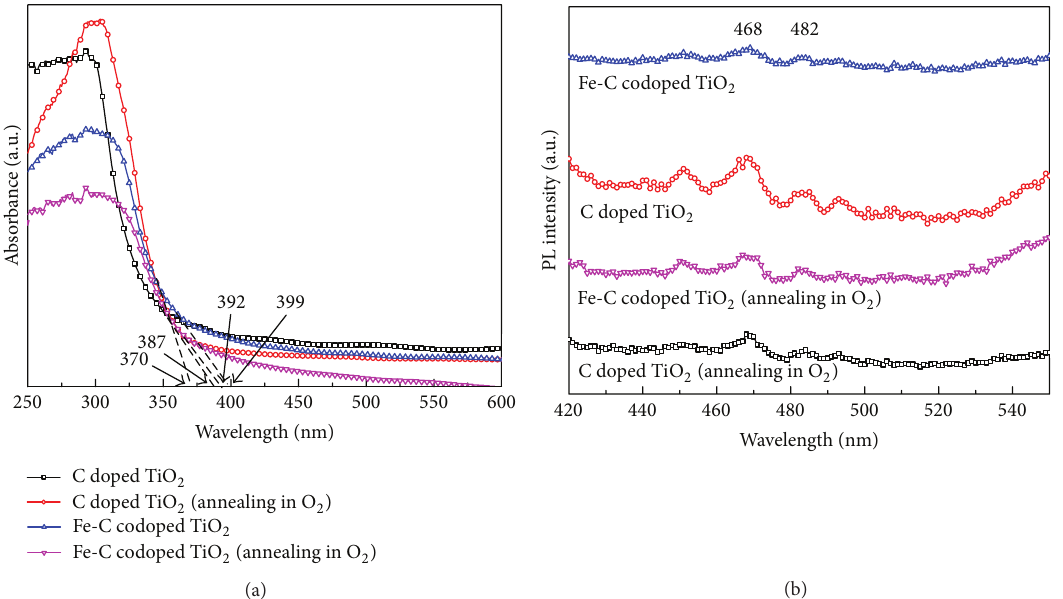
Figure 3: (a) The UV-Vis spectra and (b) PL spectra of the C doped TiO 2 films, C doped TiO 2 films (annealing in O 2 ), Fe-C codoped TiO 2 films, and Fe-C codoped TiO 2 films (annealing in O 2 ).